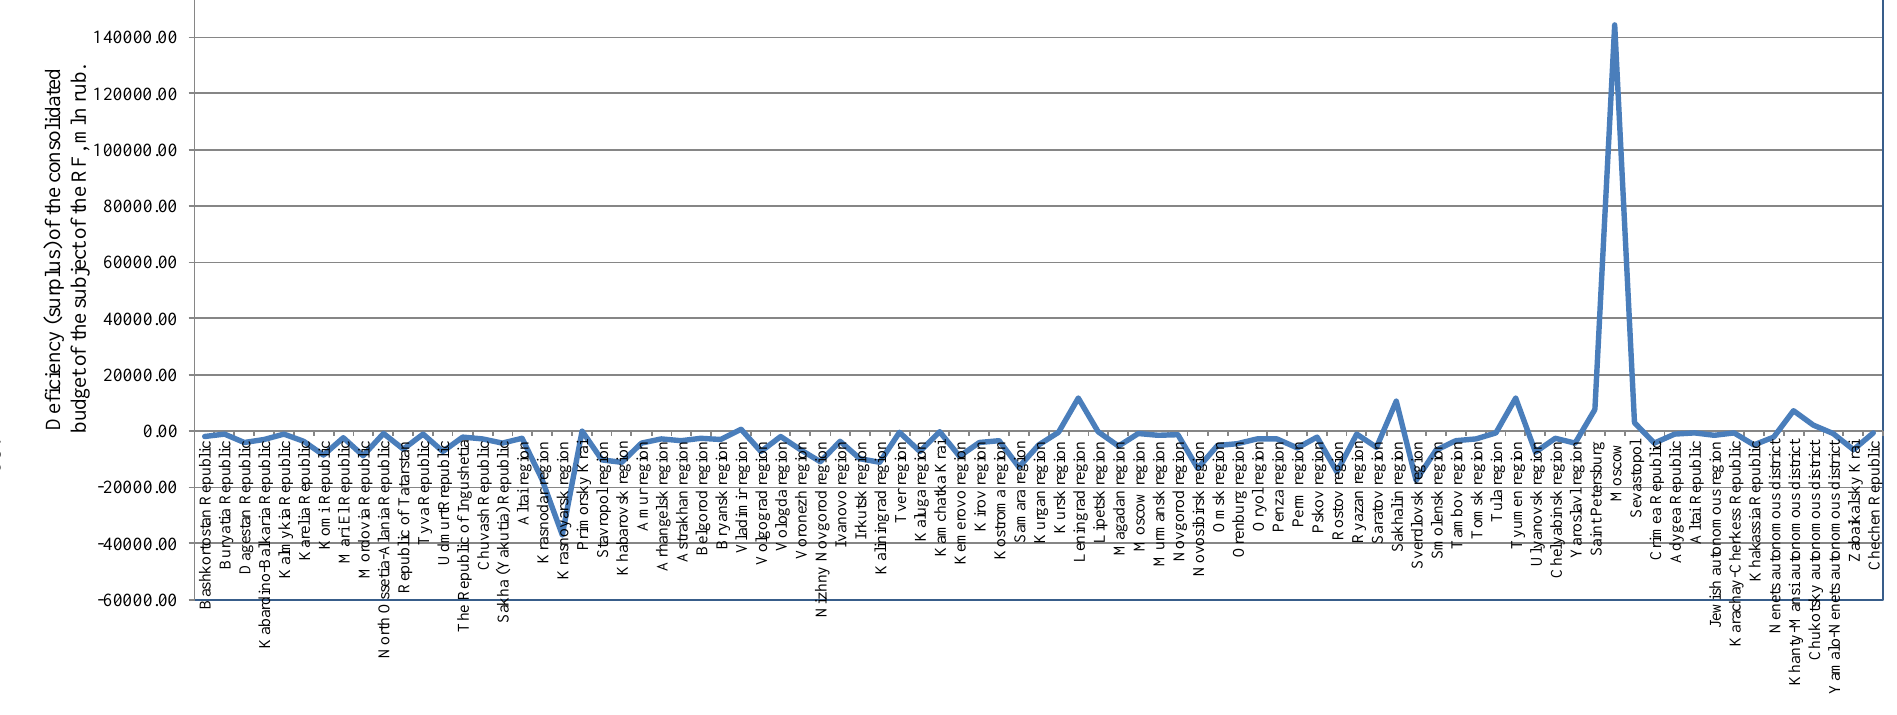
Fig. 5. The results of study of consolidated budget balance of the RF constituent entities for 2015 in mln rubles. compiled by authors to: [16]).